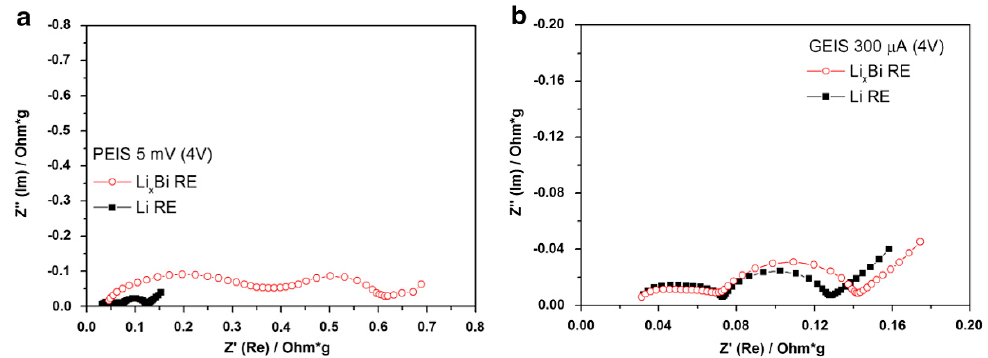
Figure 6. Electrochemical impedance spectra measured using a LiCoO 2 electrode at 4 V vs. Li + /Li with ( a ) sinusoidal potential perturbation with amplitude of 5 mV and ( b ) sinusoidal current perturbation with amplitude of 300 μ A. Figure adapted with permission from [17].